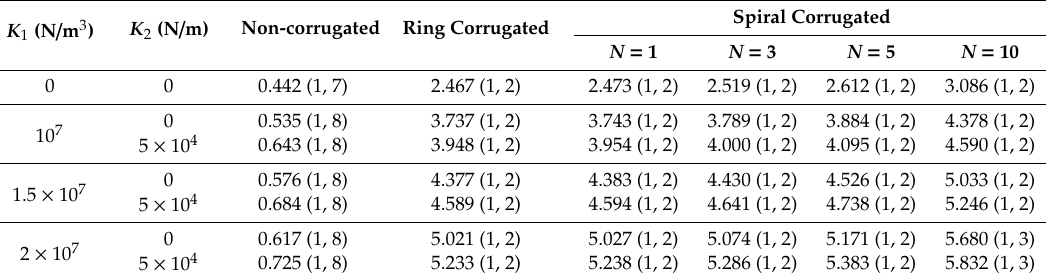
Table 7. The critical buckling pressure of trapezoidal corrugated sandwich FGM cylindrical shells with di ff erent values of elastic foundation moduli (MPa) ( e = 0.03 m , f = 0.015 m , δ = π /3, k = 1). K 1 (N / m 3 )